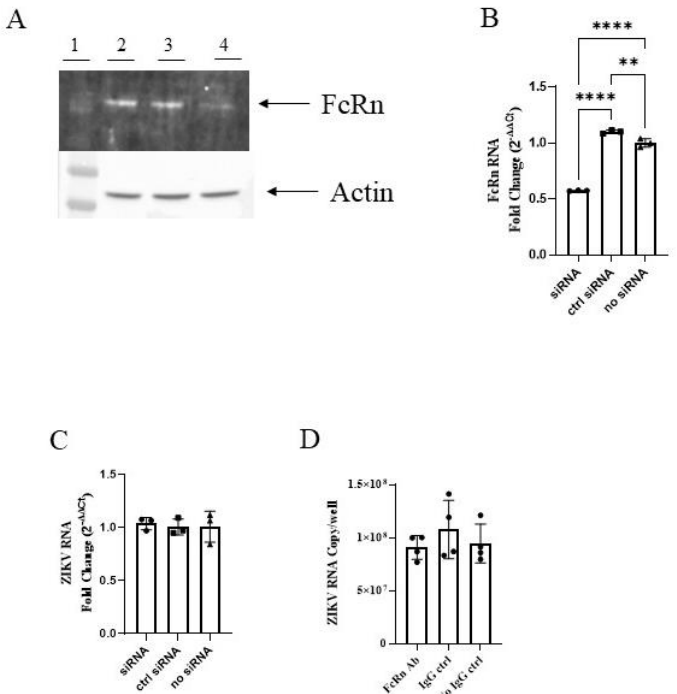
Figure 3. siRNA knockdown of FcRn in BeWo cells does not reduce ZIKV infection. ( A ) Western blot demonstrating knock-down of FcRn receptor expression in BeWo cells. Lane 1 — molecular weight marker; 2 — no siRNA; 3 — control siRNA; 4 — FcRn siRNA ( B ) RT qPCR showing knock-down expression of FcRn at the mRNA level. ( C ) No difference in ZIKV mRNA is seen in cells with siRNA knock down expression of FcRn. One representative of two independent experiments is shown ( A – C ), with at three biological repeats each cell culture analyzed by PCR ( B , C ). ( D ) No difference in ZIKV mRNA is seen in cells treated with anti-FcRn antibody before infection. One experiment, with four biological repeats was